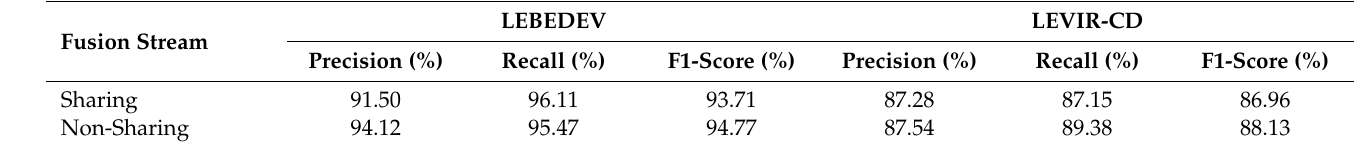
Table 4. Ablation study of fusion stream whether sharing parameters.